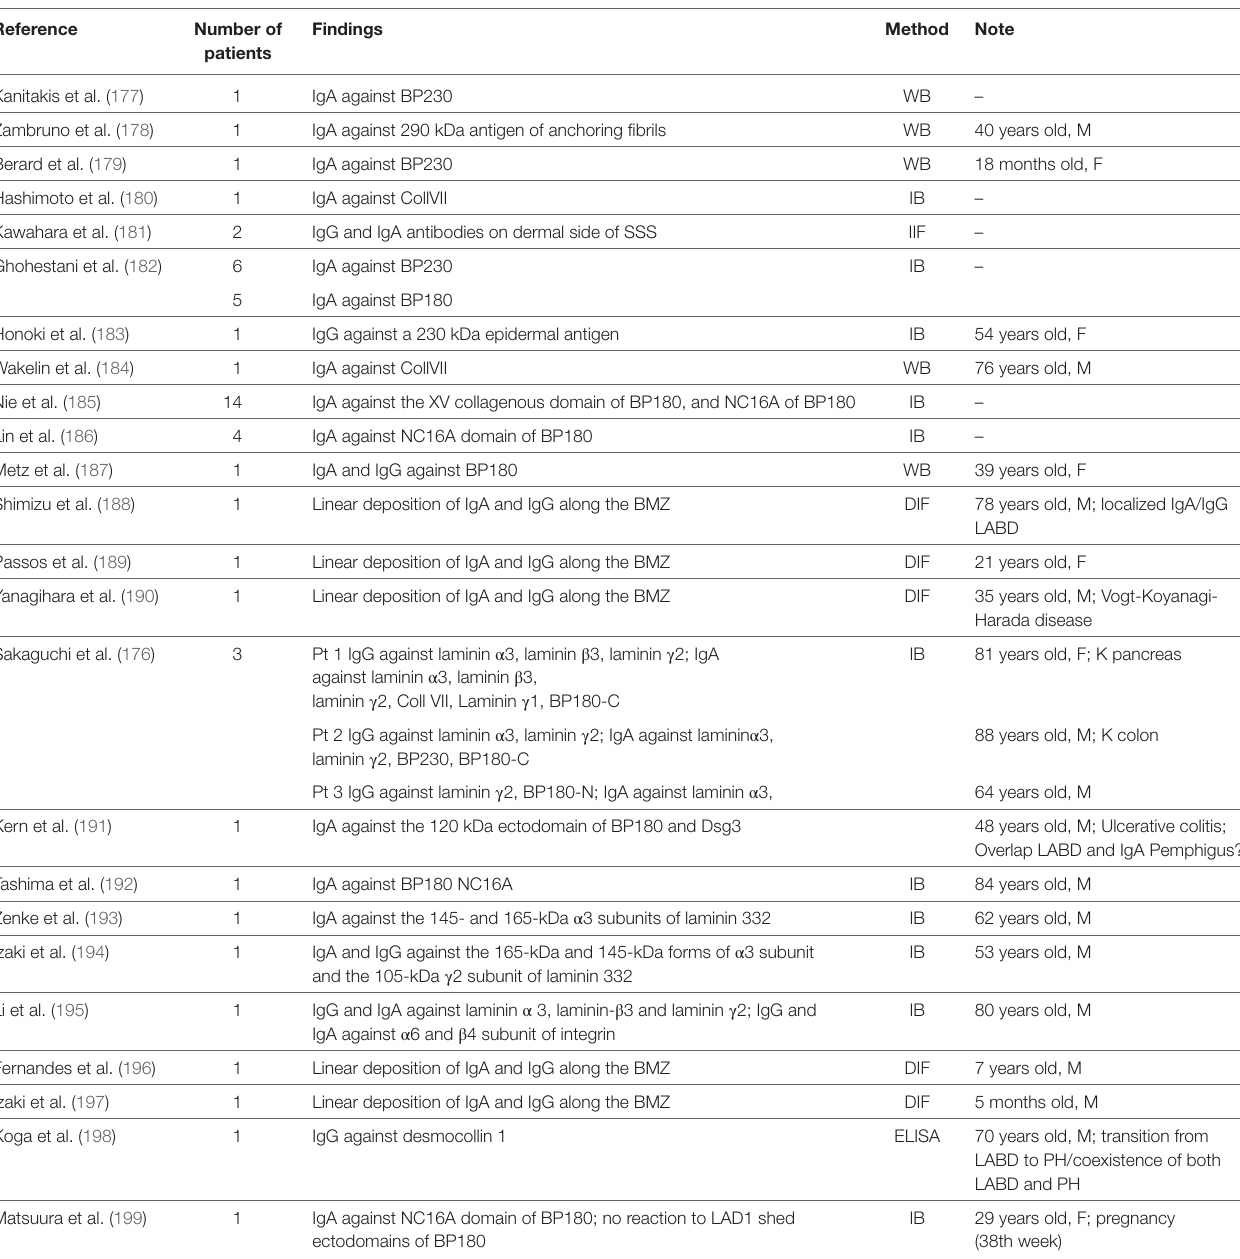
TABLe 4 | Characteristics of LABD patients with peculiar laboratory